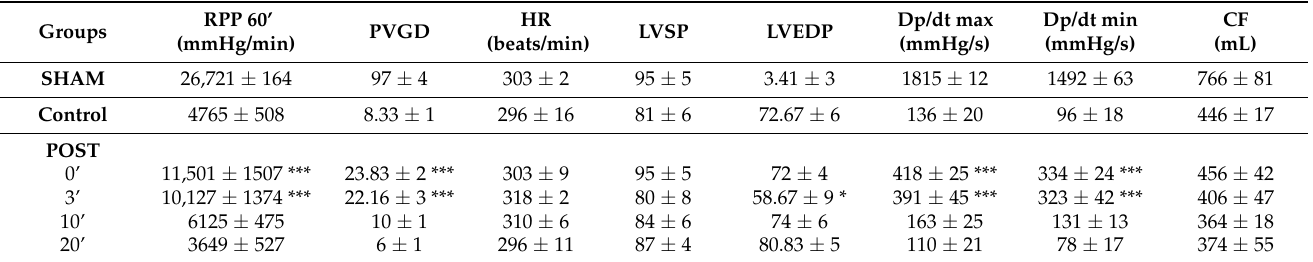
Table 1. Functional recovery assessed at reperfusion. Most functional data showed higher recovery in CsA groups until 10 min of delayed